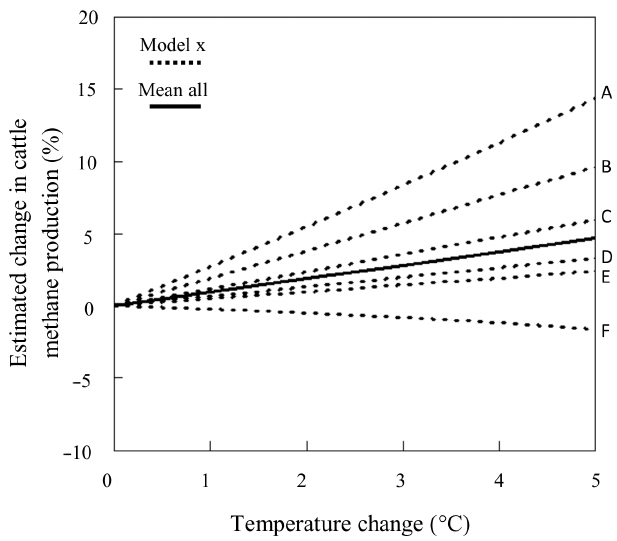
Figure 3. The estimated change in cattle methane production with temperature-derived declines in grass nutritive quality. The dotted lines represent the six model outputs as defined by equations A– F (defining the relationships between grass nutritive quality and methane production) when combined with the inverse relationship between temperature and grass nutritive quality presented in this article. The continuous line represents the mean weighted model, which is the mean methane production predicted by all six equa- tions weighted by the number of contributing